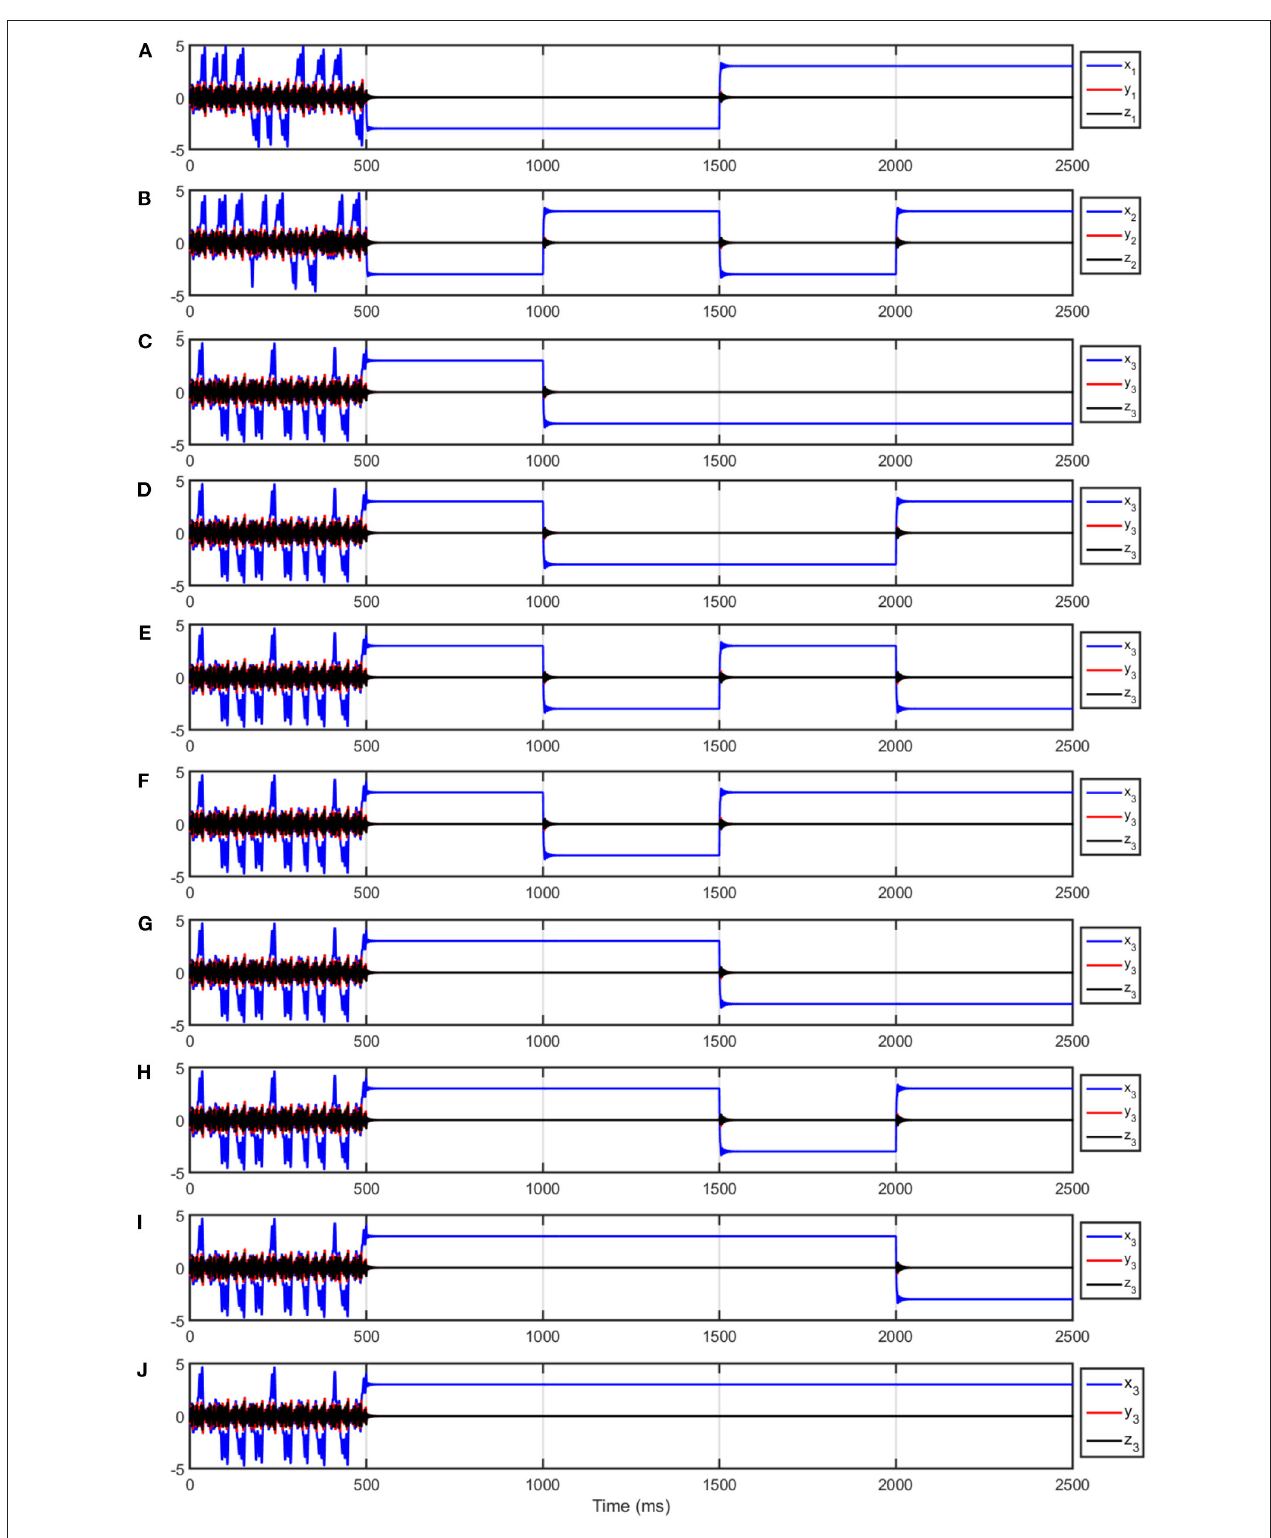
FIGURE 6 | Temporal evolution of the input nodes and for the output node emulating the logic functions shown in the lower part of Table TruthTables. The plot in (A) corresponds to the input node 1. Plot (B) corresponds to the temporal evolution of input node 2. (I 1 +I 2 )’ in plot (C) ; (I 1 ⊕ I 2 )’ in plot (D) ; I 2 ’ in plot (E) ; I 1 + I 2 ’ in plot (F) ; I 1 ’ in plot (G) ; I 1 ’ + I 2 in plot (H) ; (I 1 I 2 )’ in plot (I) ; top in plot (J)